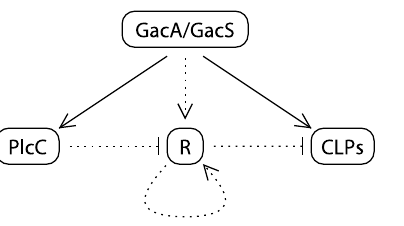
Figure 6. Hypothetic biological regulatory network of CLP production (with negative interactions) deduced from the Boolean model. Circles represent the proteins in the network and edges represent regulatory interaction (bold lines: known interactions, dotted lines: hypothetical interactions). Arrow headed edges represent positive regulatory interaction, and T-headed edges represent negative interaction. PlcC: phospholipase C; CLPs: cyclolipopeptides production; R: unknown regulator (with positive